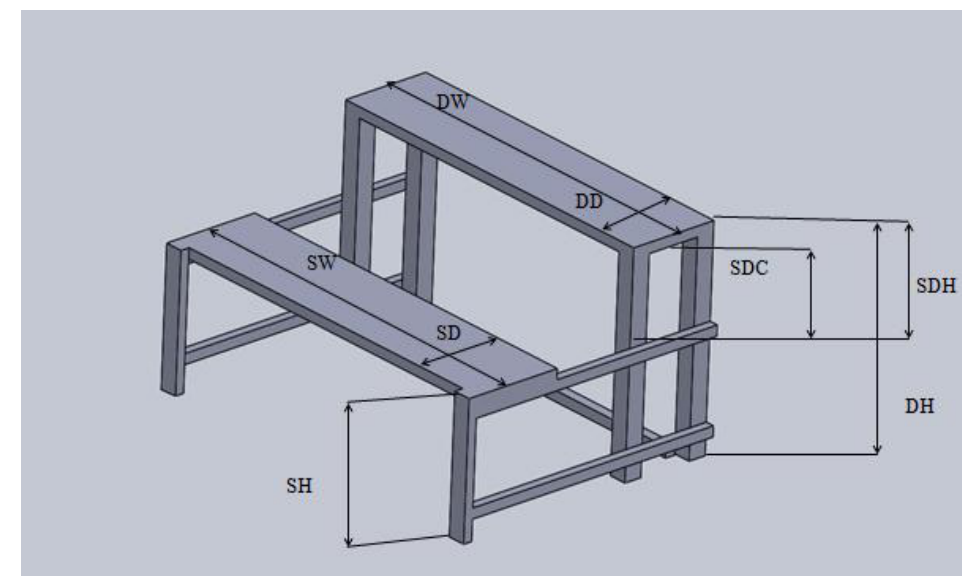
Figure 5. New designed